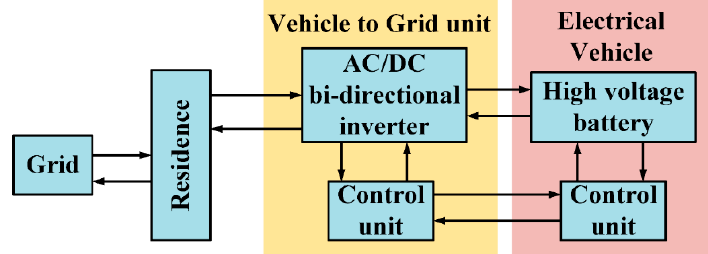
Figure 5. Block diagram of V2G and G2V for SG system. V2G and G2V together are one instance of bi-directional power flow in SG system. V2G can help in balancing the loads during peak-shaving [49].